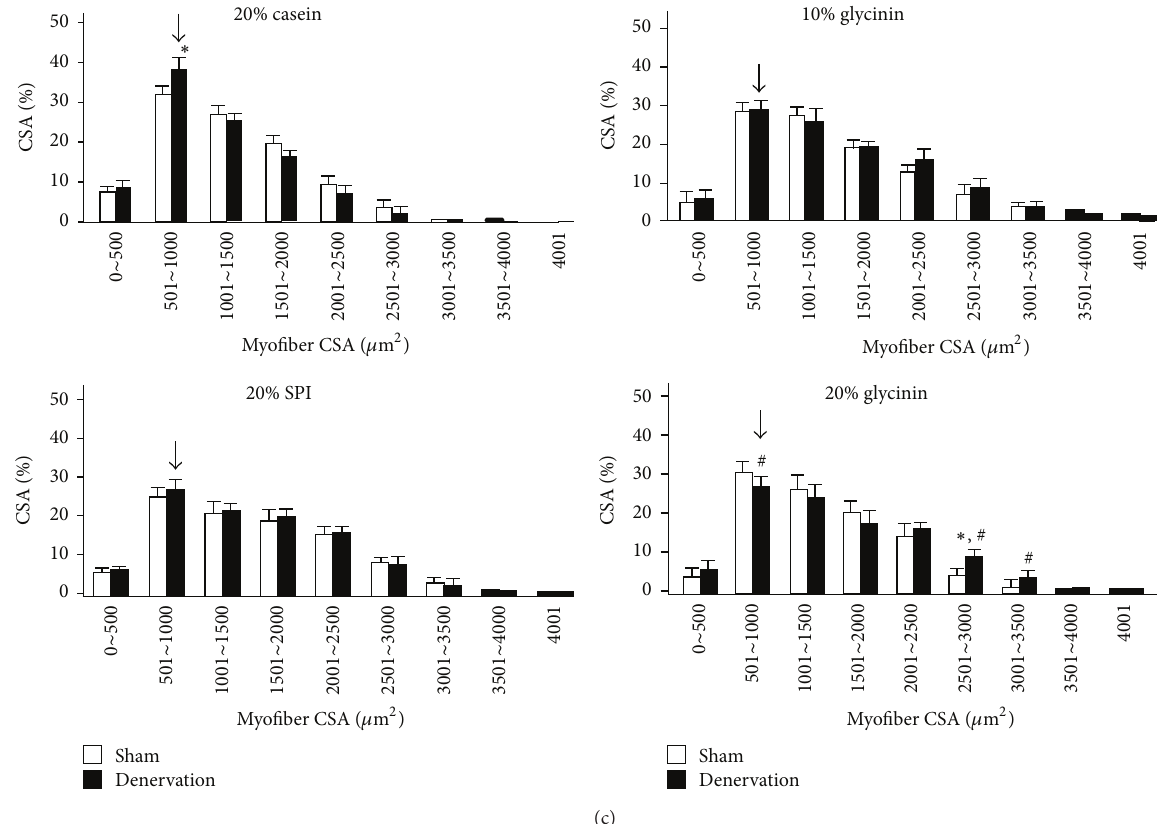
Figure 5: Effects of dietary soy glycinin protein on denervation-related decrease in muscle wet weight and muscle cross sectional area. The right and left legs of C57BL/6 mice were subjected to denervation and sham operation, respectively. Mice were divided at random into one of the following four diet groups: 20% casein group, 20% soy protein isolate group, 10% soy glycinin + 10% casein group (10% glycinin), and 20% soy glycinin group (20% glycinin). Each diet was started at 1 week before denervation and continued for the duration of the experiment period. Their hindlimb muscles were isolated at 4 days after denervation. (a) Wet weight of hindlimb muscles. Percent of denervated muscle weight was defined as the ratio of denervated hindlimb muscle wet weight to sham-operated hindlimb muscle wet weight in the mice. TA, tibialis anterior muscle; Gast, gastrocnemius muscle; EDL, extensor digitorum longus muscle; Sol, soleus muscle. Data are mean ± SD ( 𝑛 = 5 ). ∗ 𝑃 < 0.05 , versus sham operated, # 𝑃 < 0.05 , versus 20% casein diet, by the Shirley-Williams’ multiple comparison test. (b, c) Frozen sections of TA muscle were stained with H&E (b). Scale = 100 𝜇 m. The cross sectional area (CSA) of myofibers was measured as described in Materials and Methods. The distribution of CSA in TA muscle was also shown (c). Percent of CSA indicates the ratio of the number of myofibers with the indicated area to the number of total myofibers in the section. The mean value from five individual sections was shown. Arrow indicates the most common value of CSA of denervated TA muscle. Solid bars: denervation group. Open bars: sham-operated group. Data are mean ± SD ( 𝑛 = 5 ). ∗ 𝑃 < 0.05 , versus sham-operated, # 𝑃 < 0.05 , versus 20% casein diet, by the Shirley-Williams’ multiple comparison